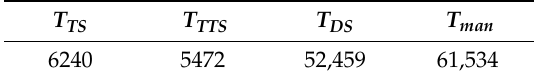
Table 2. Times to manually transcribe the training set, the test set, the dataset, and the whole collection. The times are in